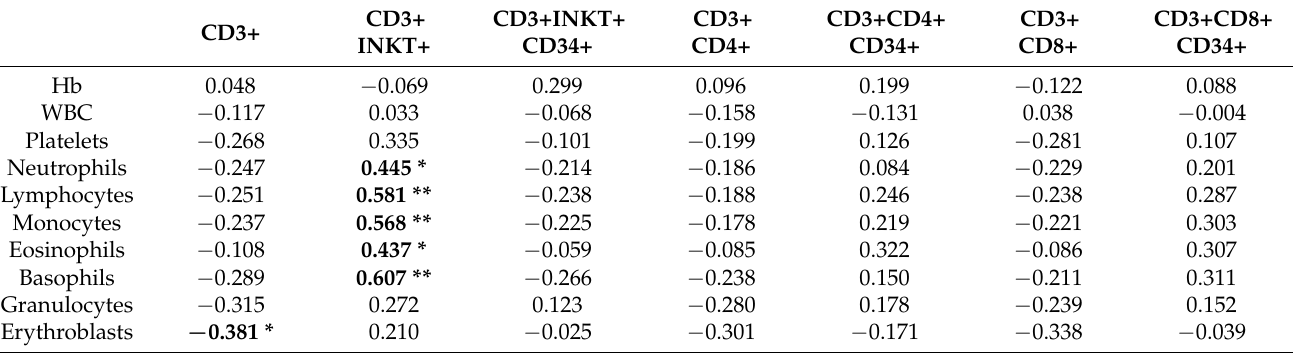
Table 11. Correlations between umbilical cord blood lymphocyte subsets and neonatal blood cells count. Pearson’s significant correlation coefficients have been